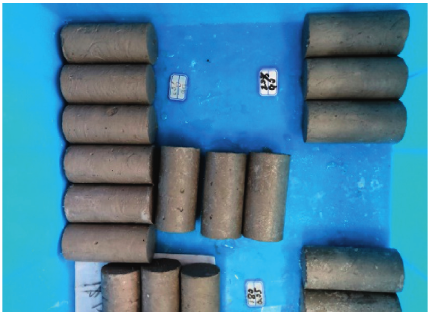
Figure 5: The demoulded cement modified slurry (CMS)